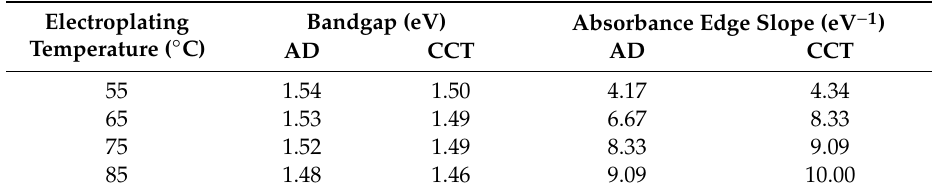
Figure 6. Optical absorption spectra for electroplated CdTe thin-films electroplated at different deposition temperature under ( a ) AD and (b ) CCT conditions. Table 3. The optical bandgap and absorption edge slope of CdTe layers electroplated from electrolytes at di ff erent